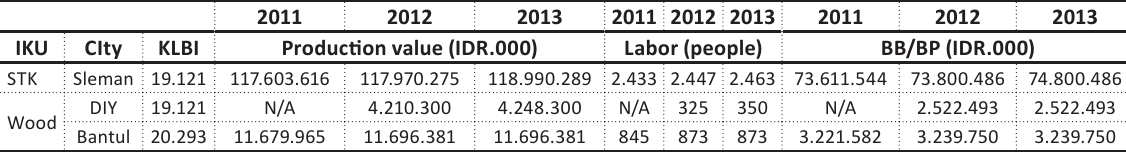
Table 2. Proportion of labor absorption and IKU raw material